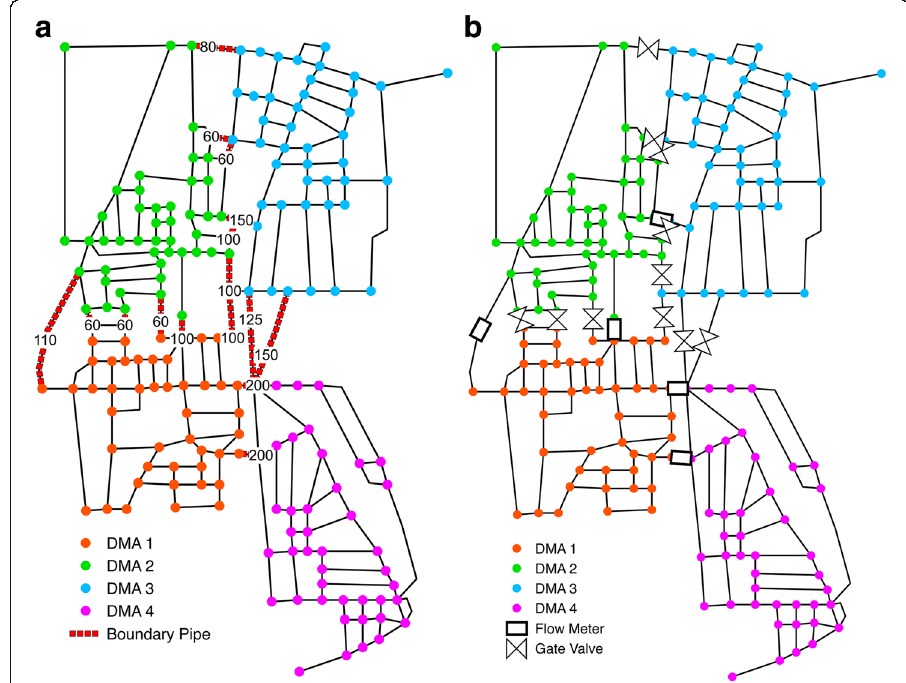
Fig. 3 Parete WSN partitioning in 4 -DMA for the unweighted graph adjacency matrix: clustering phase ( a ) and dividing phase ( b )